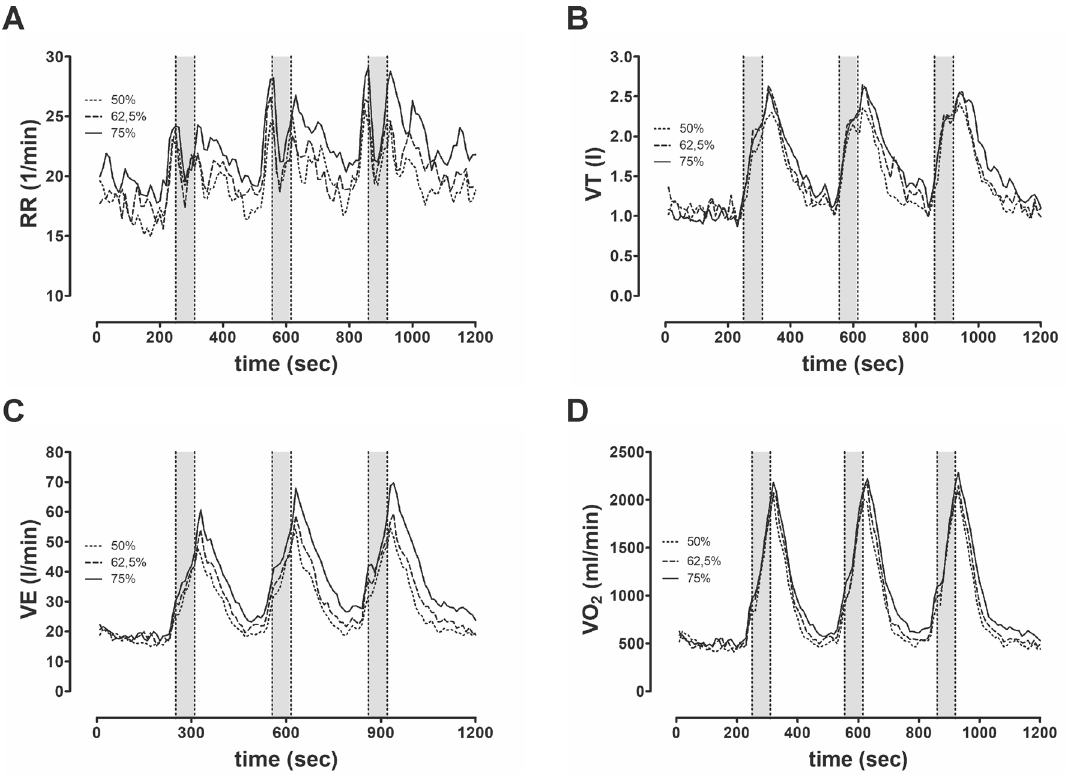
Figure 3. Graphs show the mean pulmonary response (n = 14) during strength training sessions: ( A ) respiratory rate; ( B ) tidal volume, ( C ) minute ventilation and ( D ) oxygen